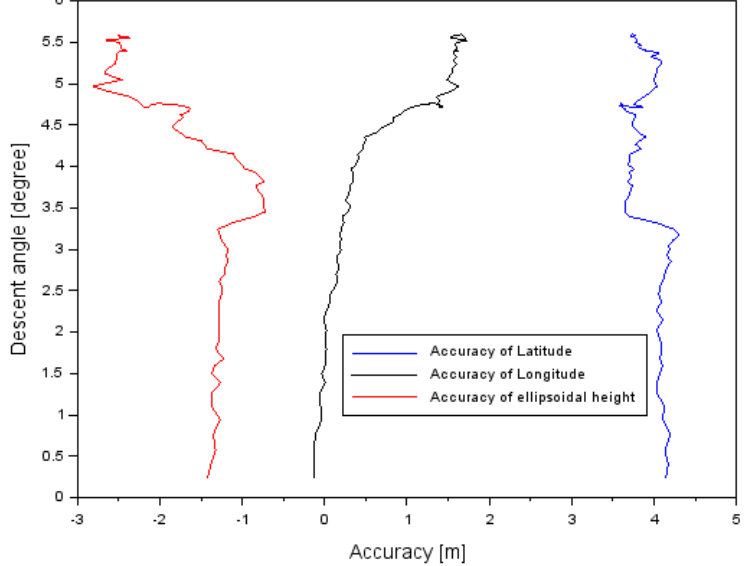
Figure 10. The descent angle in relation to accuracy results in the air test in Che ł m.